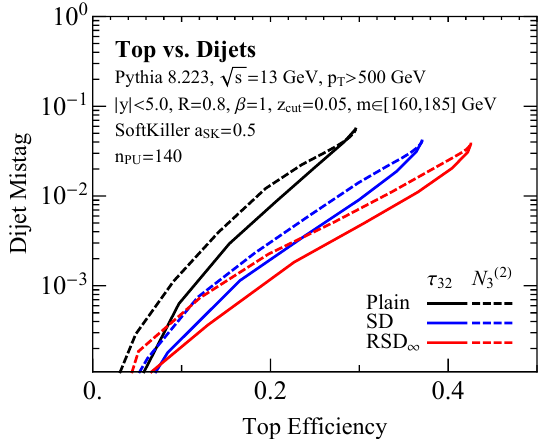
Figure 17. Same as (cid:12)gure 9, but with 140 pileup vertices and SoftKiller with grid parameter a SK = 0 :